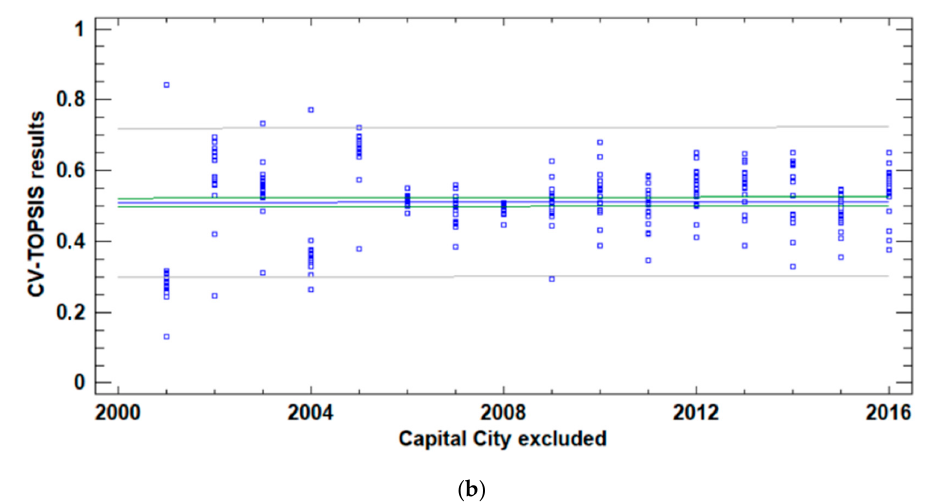
Figure 4. Comparison of regression models residuals in both variants. ( a ) regression model of CV-TOPSIS results with the capital city included; ( b ) regression model of CV-TOPSIS results with the capital city excluded.